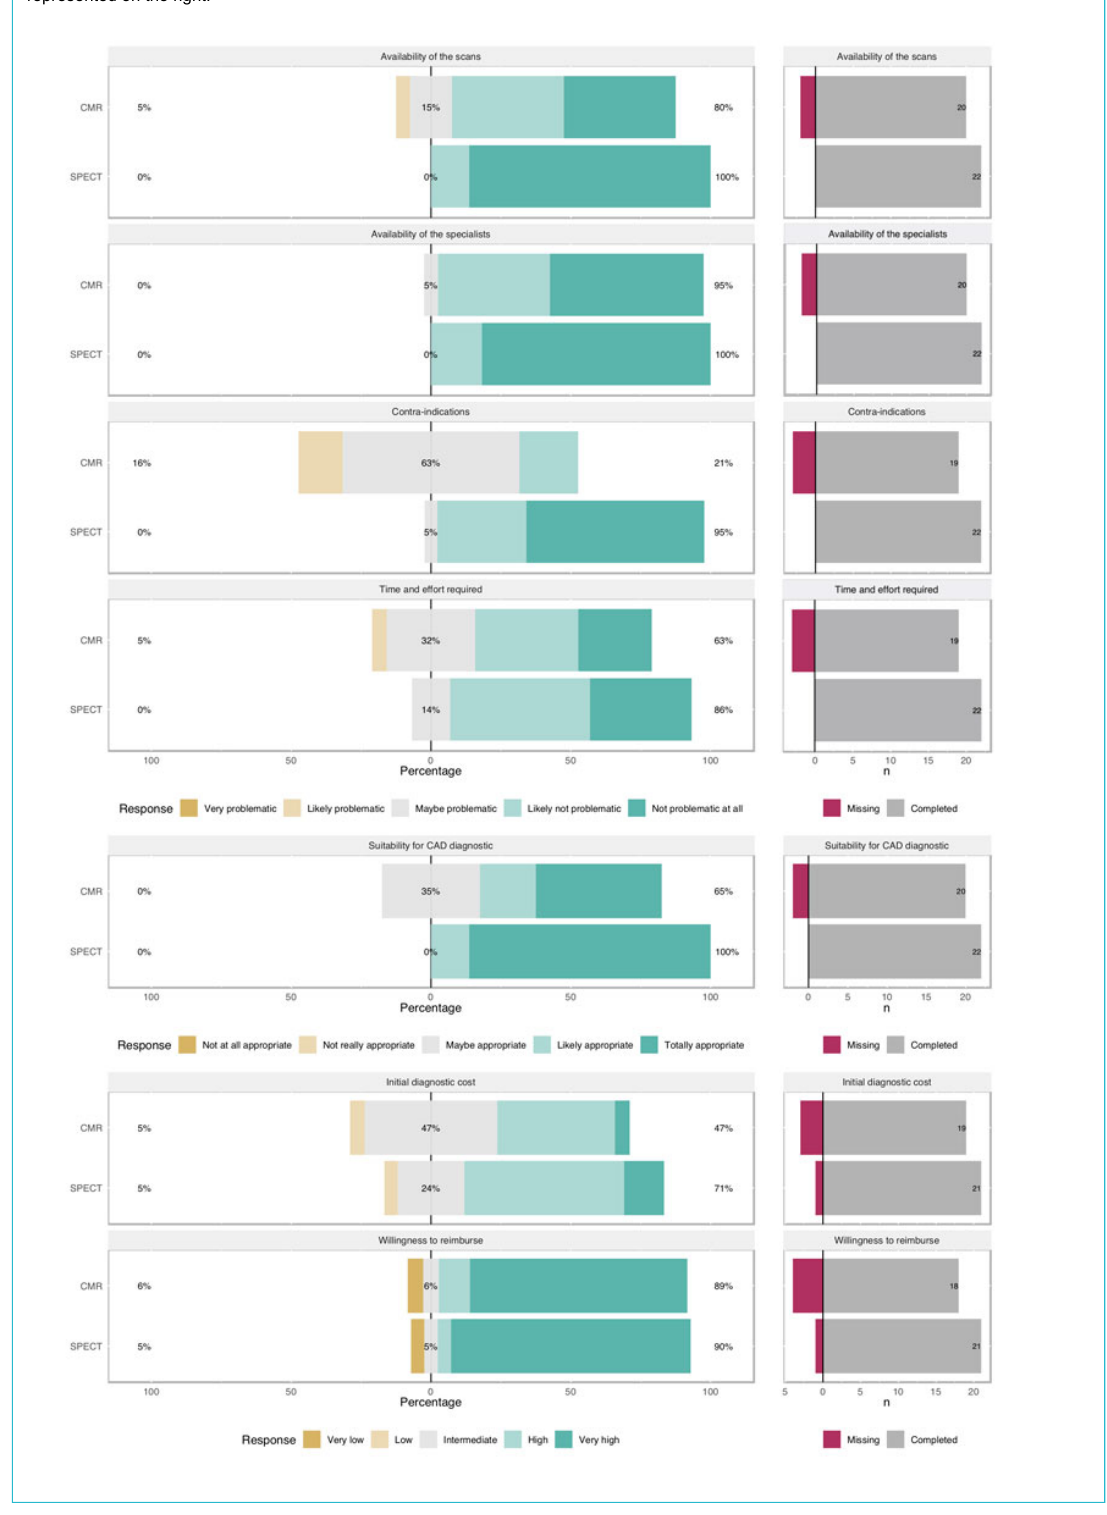
Figure 1: Answers of the 22 physicians to the questionnaire. The percentages of answers given for each level of the Likert scale (from the most negative to the most positive answers) are represented on the left. The numbers of missing answers per question and technology are represented on the